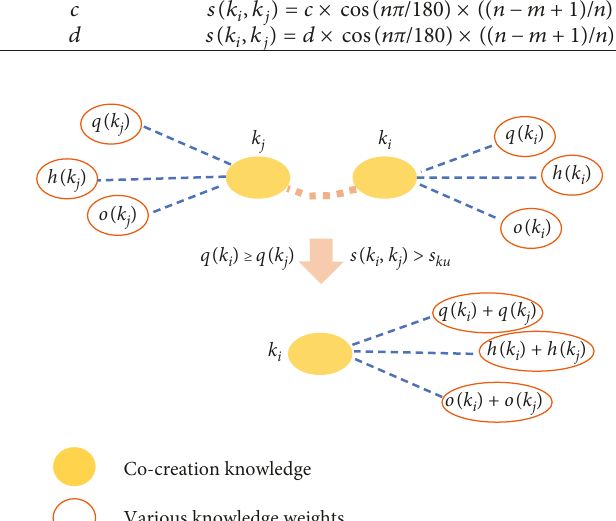
Figure 6: Knowledge points merging process.